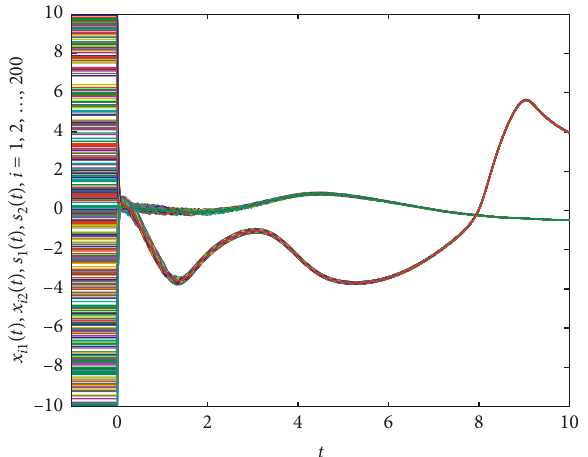
Figure 18: Time evolution of synchronization errors e ( t ) , x ( t ) , and s ( t ) i 1 i 2 under sampled-data feedback, i � 1 , 2 , ... , 200.